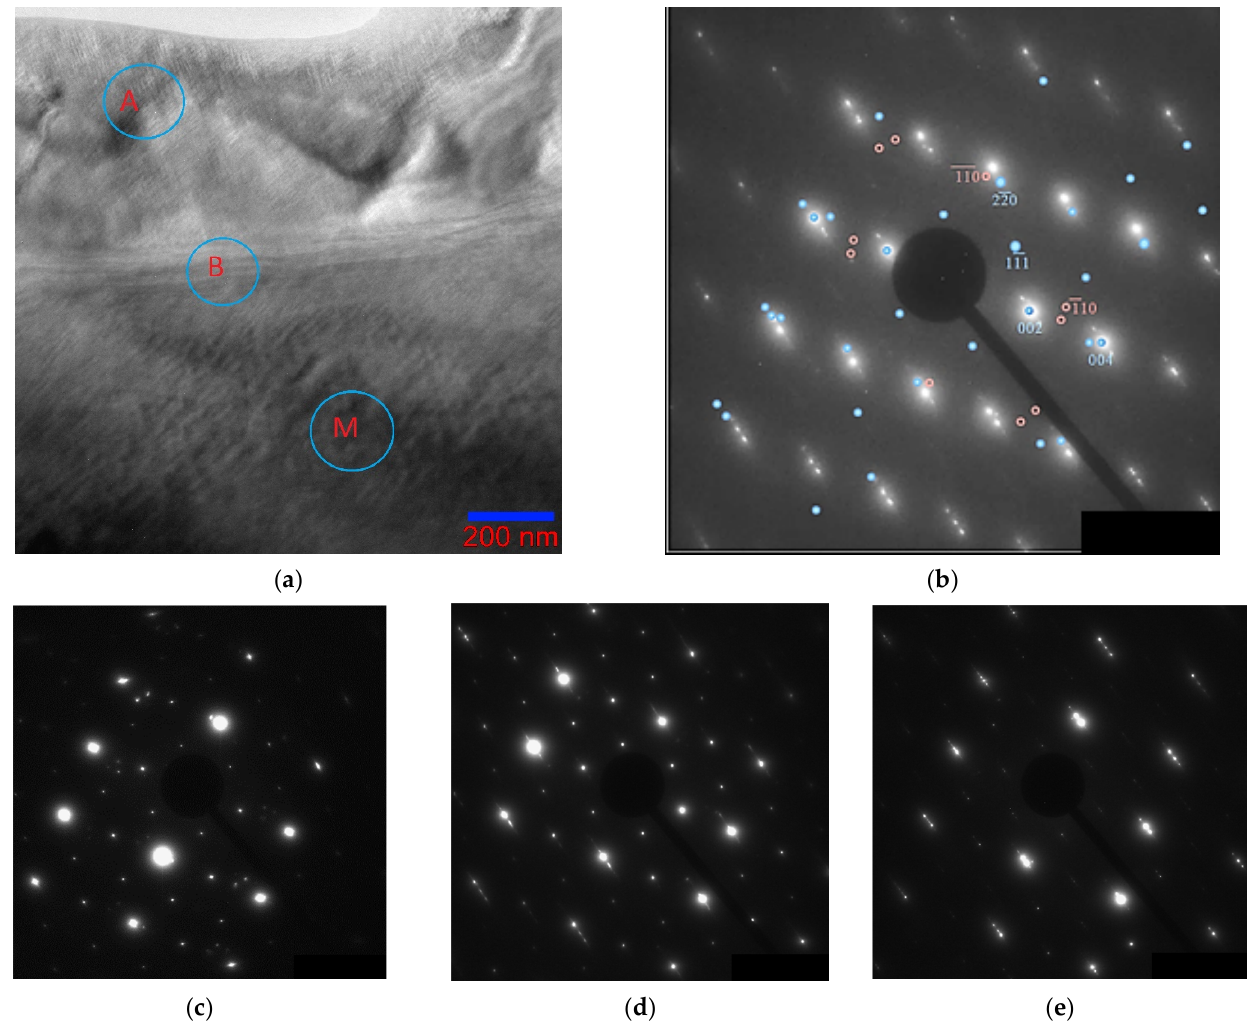
Figure 12. Structures of the Ni 46 Mn 41 In 13 alloy at the A–M interface at 215 K: bright-field image ( a ), combined austenite–martensite electron diffraction pattern ( b ), electron diffraction patterns from the austenite region ( c ), A–M (“B” in circle) boundary ( d ) and martensite ( e ). Zone axis [110] L21 .